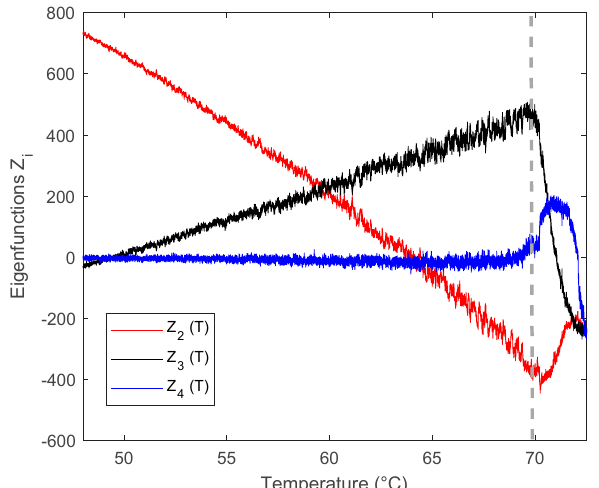
Figure 3. Temperature behavior of three of the first four eigenfunctions for a droplet of stearic acid (SA).